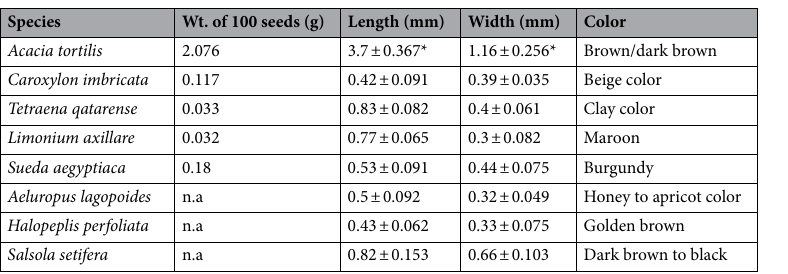
Table 2. Characterization of seeds for the studied species. *Values are means ± Standard deviation (n = 10). n.a.: data not available.